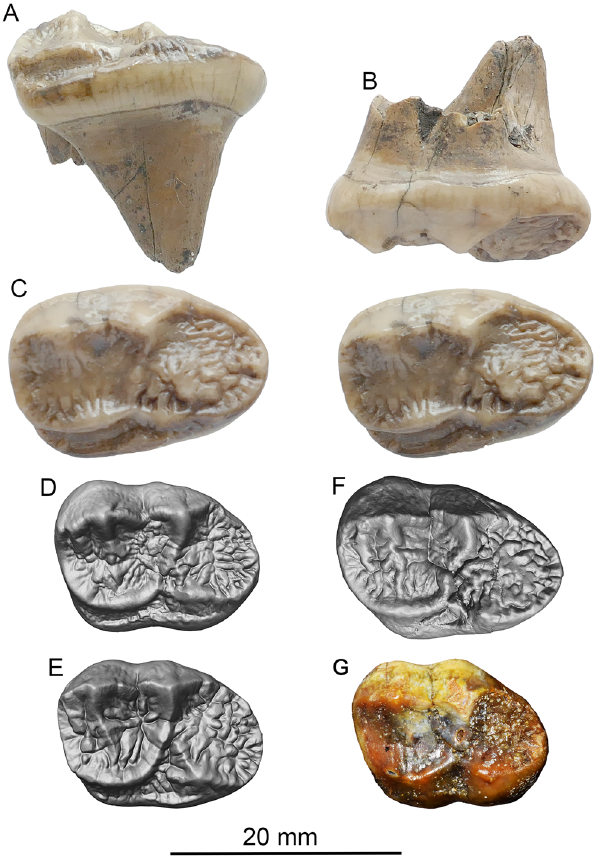
Figure 2. Ailurarctos cf. A. lufengensis from Zhaotong ( A – C ) compared to A. lufengensis from the type locality of Lufeng ( D – F ) and A. yuanmouensis from type locality of Yuanmou ( G ). ZT-2015–0124, ( A ) lingual, ( B ) labial, and ( C ) occlusal (stereophoto) of left M2; ( D ) right M2 (reversed), IVPP V6892.4; ( E ) left M2, IVPP V6892.5, and ( F ) left M2, IVPP V6892.6; and ( G ) left M2, YV 2509.2, A. yuanmouensis . Images for A. lufengensis and A. yuanmouensis are courtesy of Qigao